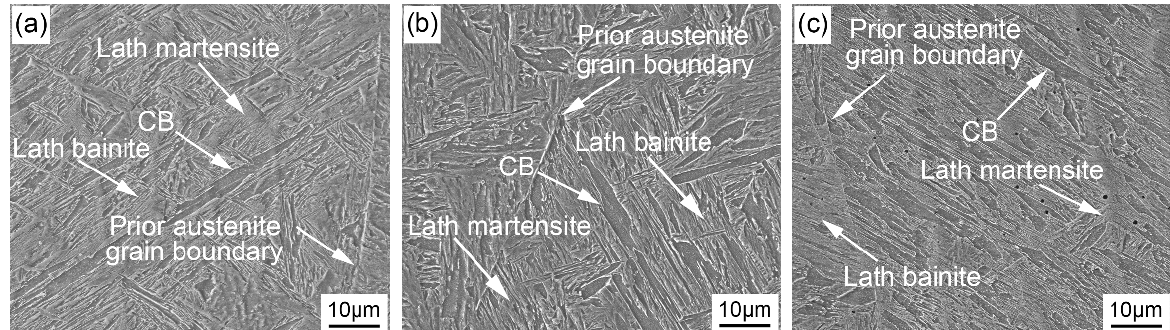
Figure 5. SEM images of the deposited metals: ( a – c ) microstructure of the column zone of Ni5.5, Ni6.5, and Ni7.5, respectively; CB is the abbreviation for coalesced bainite; these SEM images were taken at 4000 times by the FEI Inspect F50.